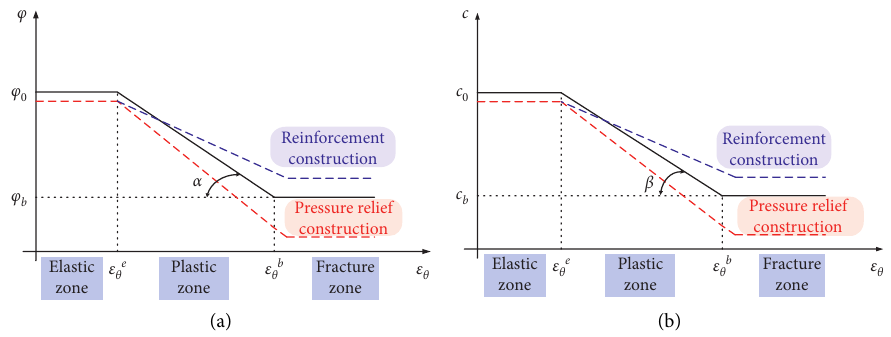
Figure 9: Surrounding rock softening model in a roadway: (a) the softening models for internal friction angle φ of surrounding rock mass; (b) the softening models for cohesion c of surrounding rock